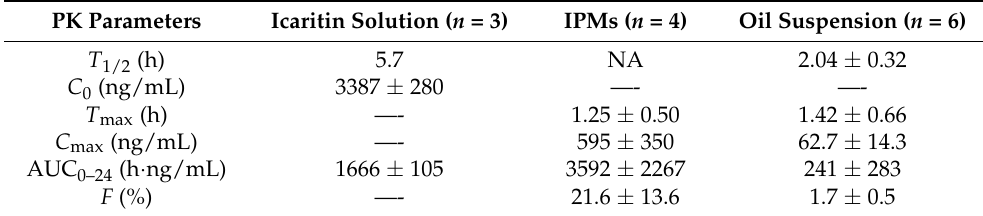
Table 2. Pharmacokinetic parameters after injection of icaritin solution, and oral administration of IPMs and oil suspension to beagle dogs at a dose of 2 mg/kg and 20 mg/kg,